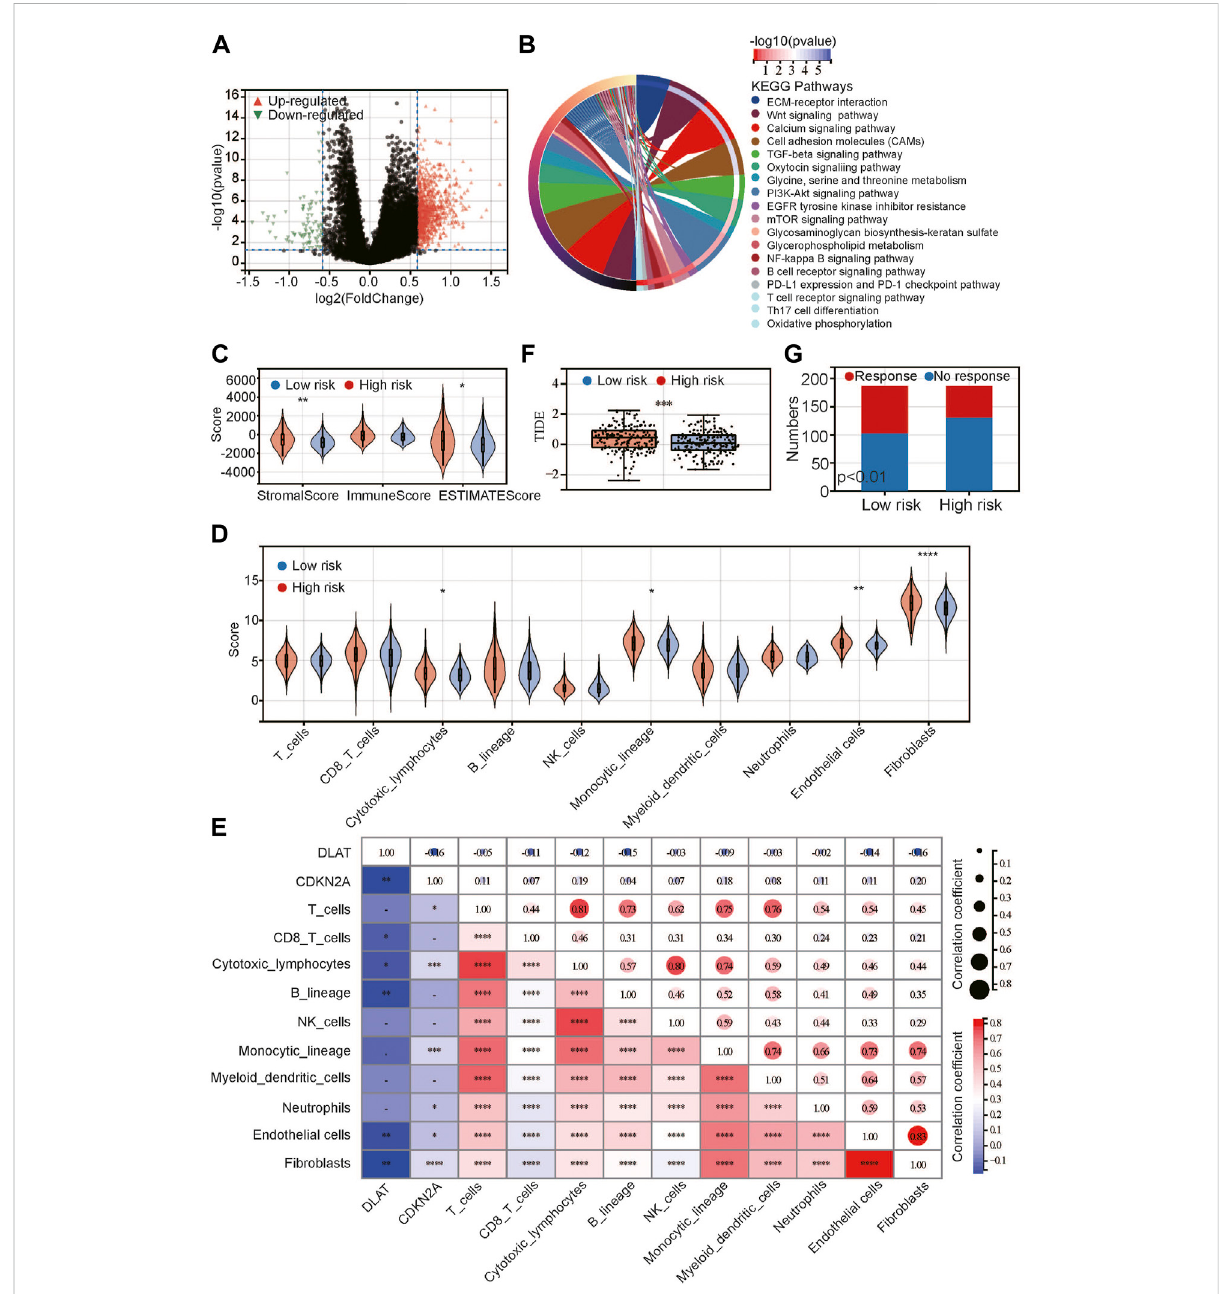
Relationship between risk score and immune/stromal in fi ltration. (A) Volcano plot of differentially expressed genes; (B) KEGG pathway enrichment between low- and high-risk groups; (C , D) Difference between low- and high-risk groups by ESTIMATE (C) and MCP-Counter (D) algorithms; (E) Correlation between CRGs and immune-related scores; (F) Difference between low- and high-risk groups in TIDE score; (G) Predicted response for immunotherapy. * p < 0.05, ** p < 0.01, *** p < 0.001, **** p <